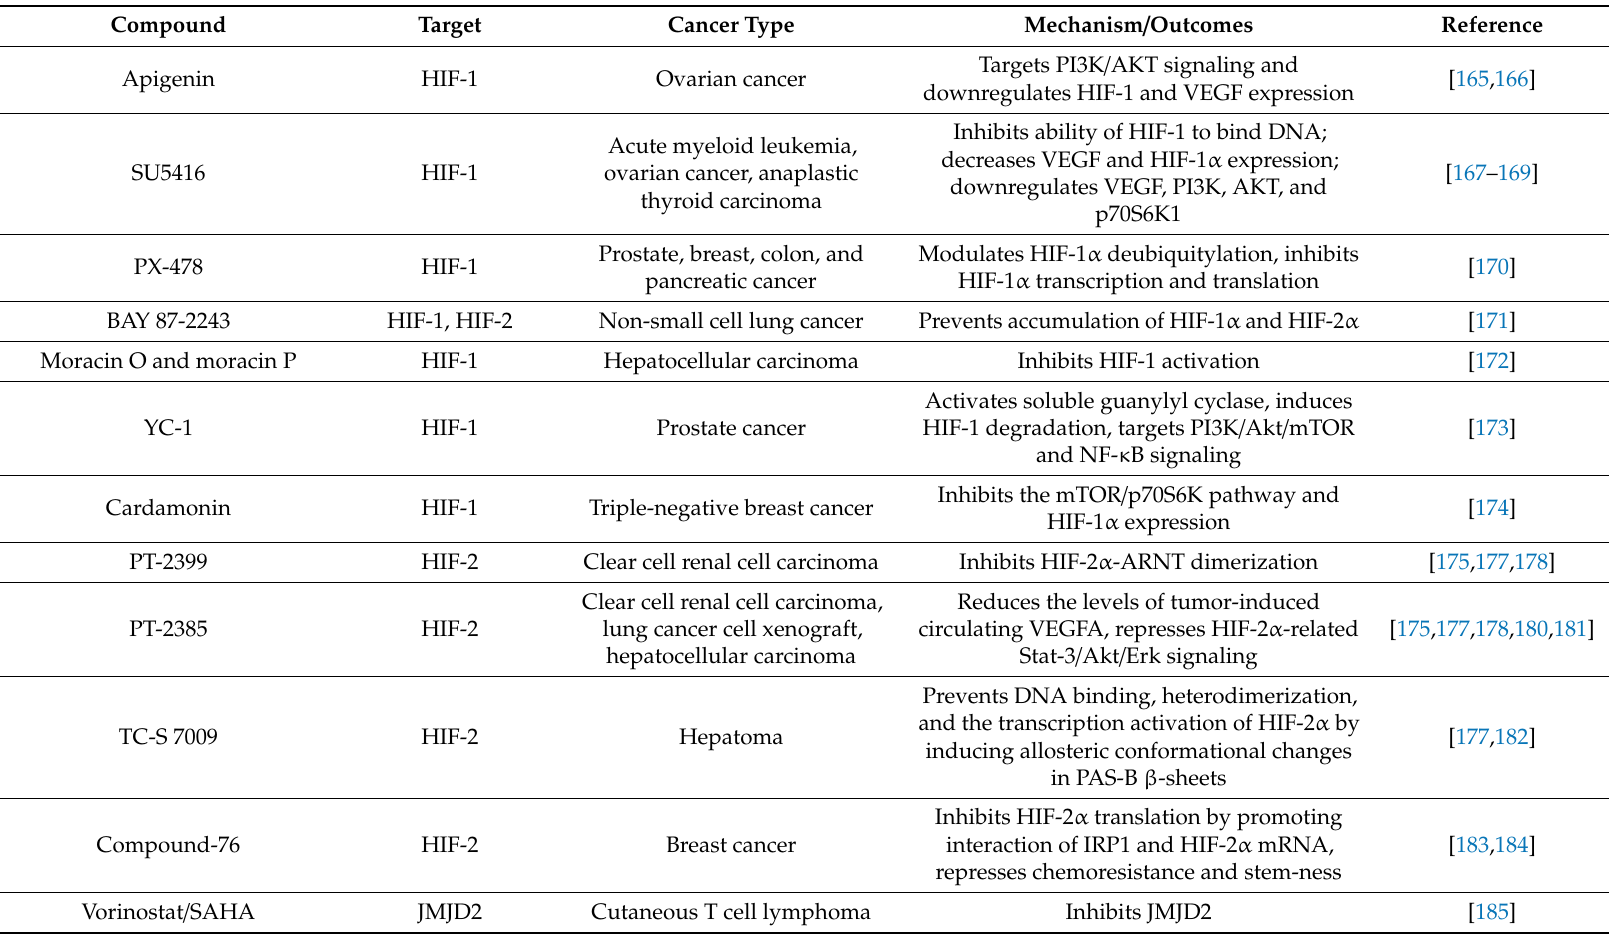
Table 1. Compounds that have been shown to target HIF